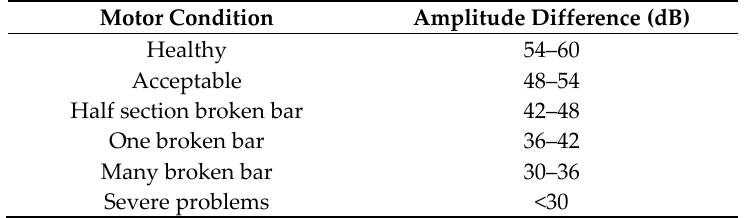
Figure 8. FFT spectrum of the current signal of a motor with a broken bar, as shown in [33]. Reproduced with permission from IEEE, 2017. Table 12. Difference of amplitude between the fundamental harmonic and